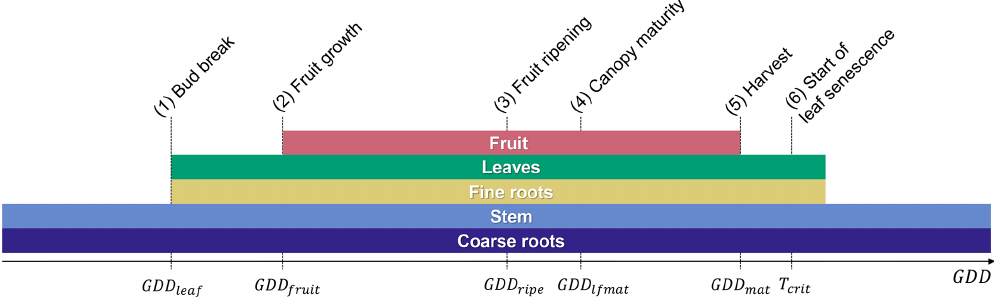
Figure 2. Fruit tree phenological stages of (1) bud break at the end of dormancy, (2) the start of fruit growth, (3) fruit ripening, (4) canopy maturity, (5) harvest, and (6) the start of leaf senescence. The lengths of phenological stages (2)–(5) are determined by their respective grow- ing degree-day (GDD) thresholds starting from bud break (GDD leaf = 0), while stage (6) is determined by a critical temperature threshold ( T crit ). Coloured bars correspond to the time any plant organ is present in the field throughout a